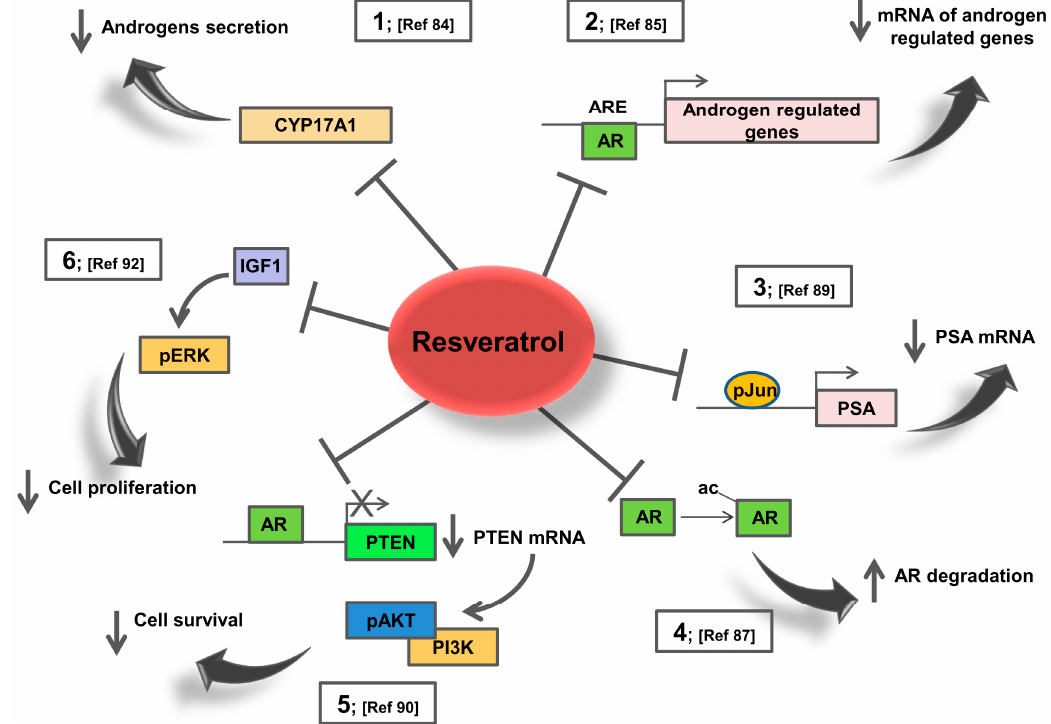
Figure 2. Summary of Resveratrol effects on AR dependent pathways. 1. RSV reduces the production of adrenal androgens, via inhibition of CYP17A1 in adrenocortical cells. 2. RSV represses different classes of androgen up-regulated genes in prostate cancer cells. 3. RSV decreases the transcriptional activity of AR through c-Jun specific DNA binding activity in prostatic cancer cells. 4. RSV decreases the ligand-induced nuclear accumulation of AR reducing its acetylation status in prostate cancer cells. 5. RSV inhibits PI3K activity by stimulating PTEN expression and decreasing AR action in LNCaP cells. 6. RSV decreases IGF-1 and ERK1 phosphorylation in transgenic adenocarcinoma mouse model of prostate cancer.